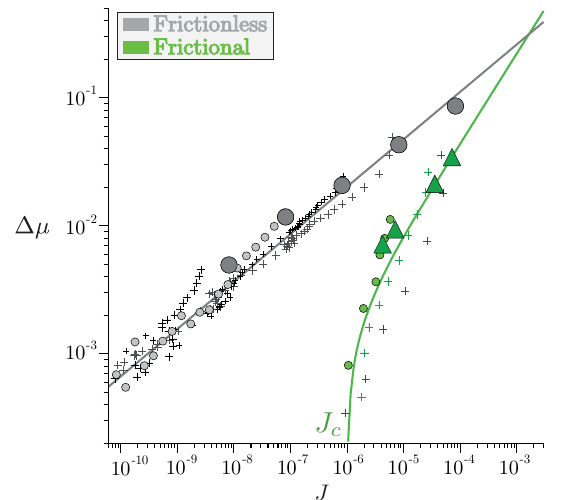
FIG. 4. Reduced macroscopic friction coefficient Δ μ ¼ μ − μ 0 versus viscous number J for frictional and frictionless particles immersed in solutions of ionic concentration ( ½ NaCl (cid:3) ¼ 10 − 1 and 10 − 6 mol · L − 1 , respectively). Large markers were obtained from the steady-state measurements presented in Figs. 3(a) – 3(c). Small markers correspond to transient relaxations measurements from different initial steady states as described in Figs. 3(d) – 3(f). Solid lines are fits (in grey) by Δ μ ¼ ð J=J 0 Þ α , with α ¼ 0 . 37 (cid:2) 0 . 05 and J 0 ≈ 2 . 27 × 10 − 2 , for frictionless particles and (in green) by Δ μ ¼ ½ð J − J Þ =J (cid:3) β , with β ¼ 0 . 7 (cid:2) 0 . 3 , J ≈ 8 . 69 × 10 − 3 and 0 0 c ≈ 10 − 6 , for frictional particles. J c